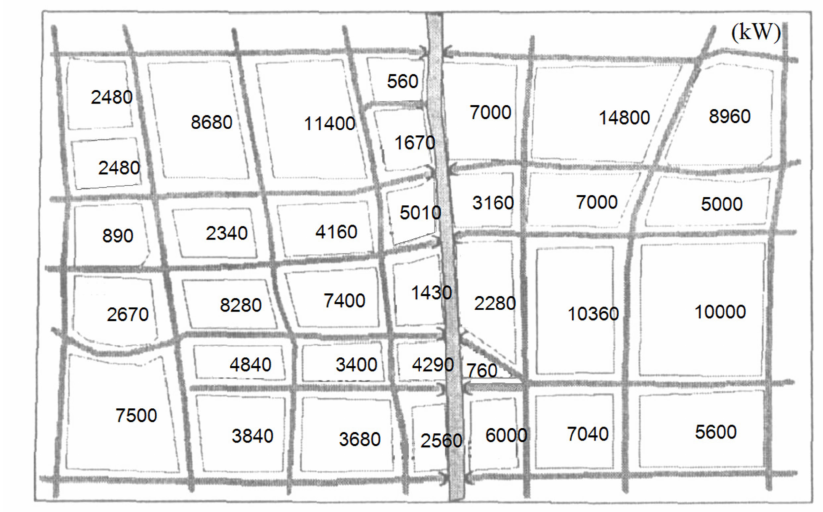
Figure 2. Power load in each area.